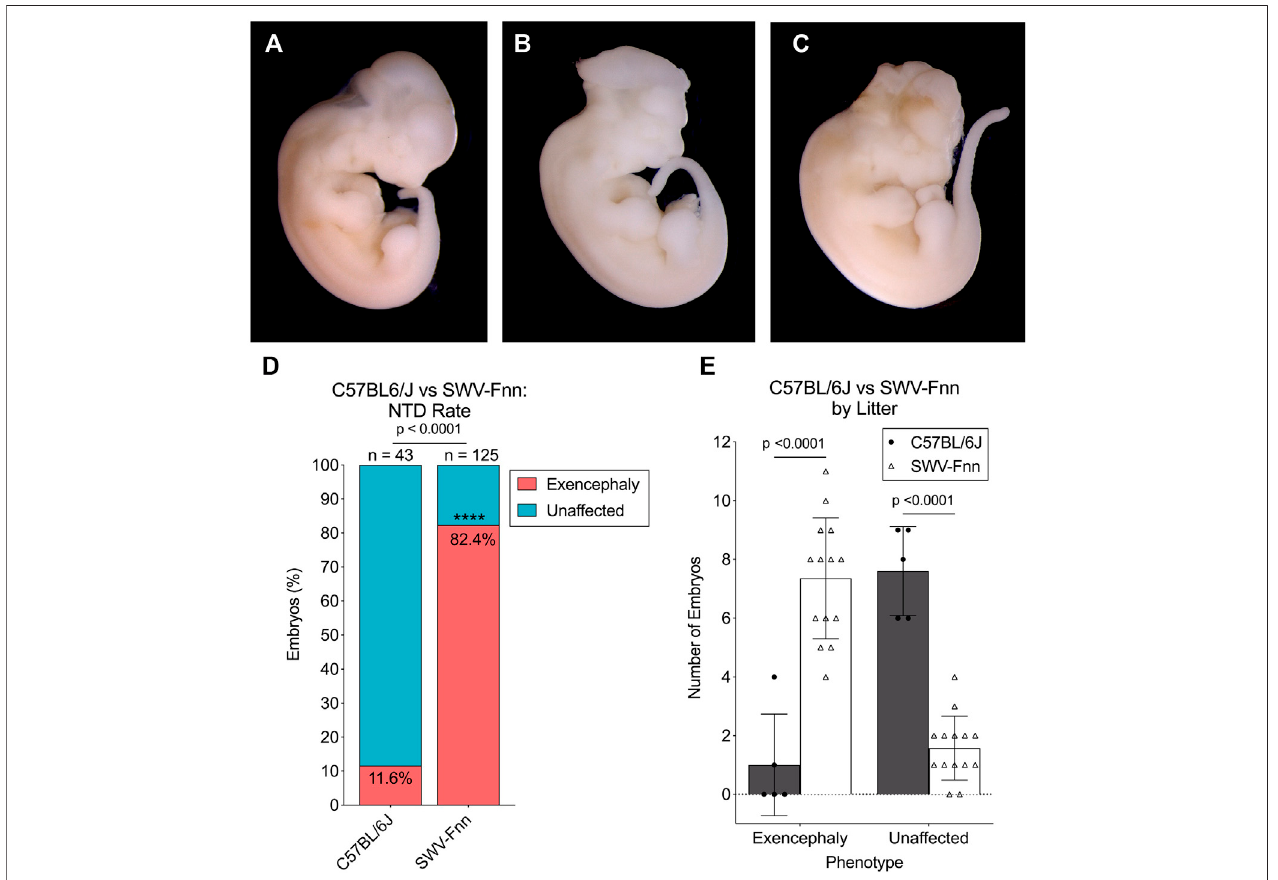
FIGURE 1 | Strain-dependent susceptibility to VPA con fi rmed in SWV embryos. (A) Image of unaffected E12.5 SWV embryo exposed to 600 mg/kg VPA, appearingdevelopmentallynormal. (B,C) TwoexamplesofE12.5SWVembryospresentingexencephalyphenotypesafterexposuretoVPA(600 mg/kg). (D) Proportion ofembryoswithexencephalyphenotypesinC57BL/6J(C57)andSWV-Fnn(SWV)littersexposedto600 mg/kgVPA.*Statisticalsigni fi cancedeterminedbytwo-sample proportion test ( α < .05). (E) Number of exencephalic versus unaffected embryos in each C57 or SWV litter exposed to 600 mg/kg VPA. *Statistical signi fi cance determined by two-way ANOVA with Š ídák ’ s multiple comparisons ( α <